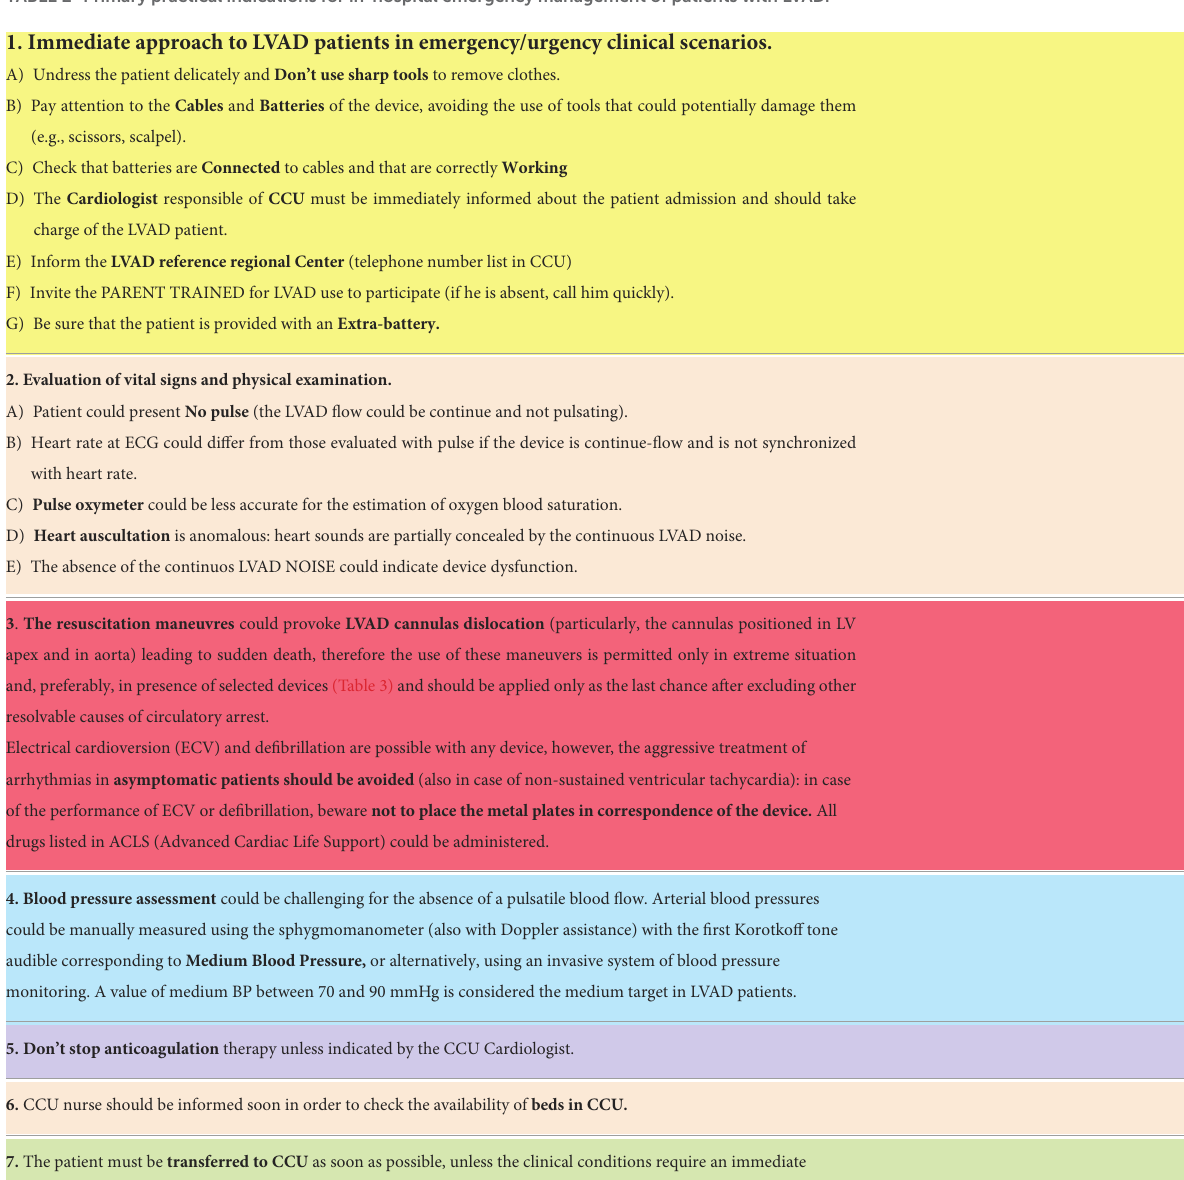
TABLE 2 Primary practical indications for in-hospital emergency management of patients with